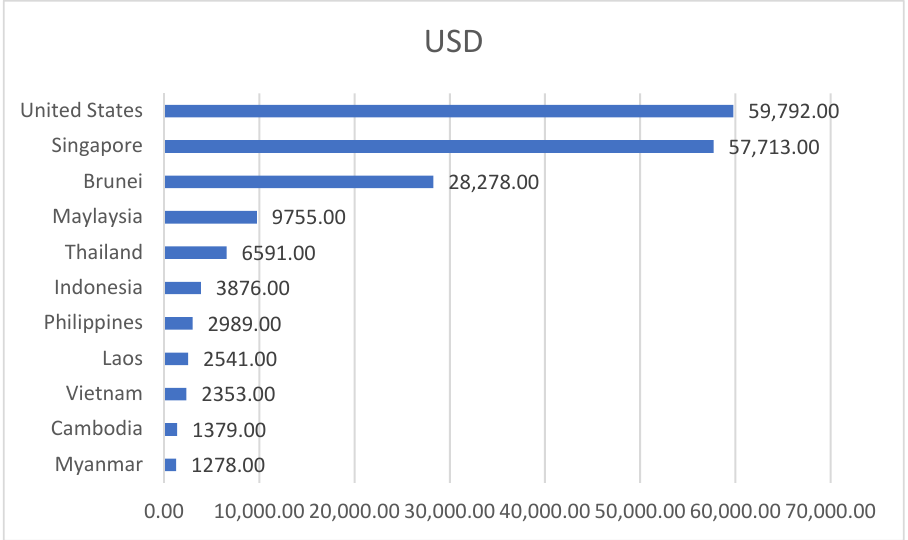
Figure 1. Per capita GDP of the ASEAN economies as compared to the US in 2017. Source: East-West Center, 2019 [24].